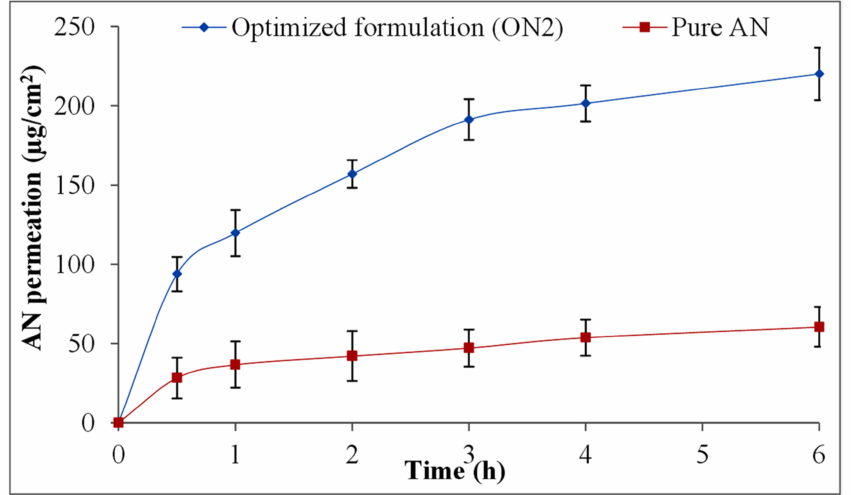
Figure 10. Ex vivo permeation study graph of pure Apigenin and optimized formulation (ON2). The study was performed in triplicate and data shown as mean ±